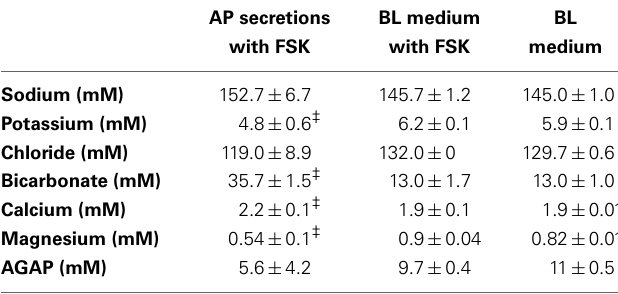
Table 1 | Analysis of Calu-3 secretions and basolateral media * .